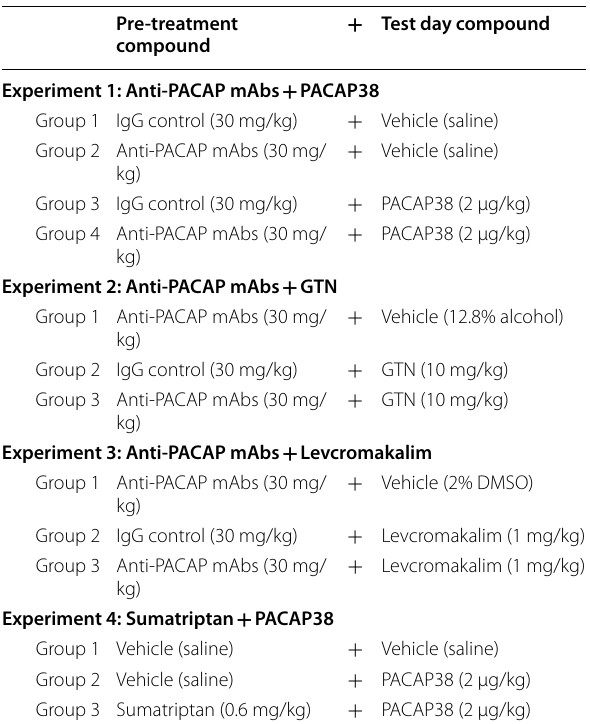
Table 1 Overview of the experiments, test groups ( n compounds